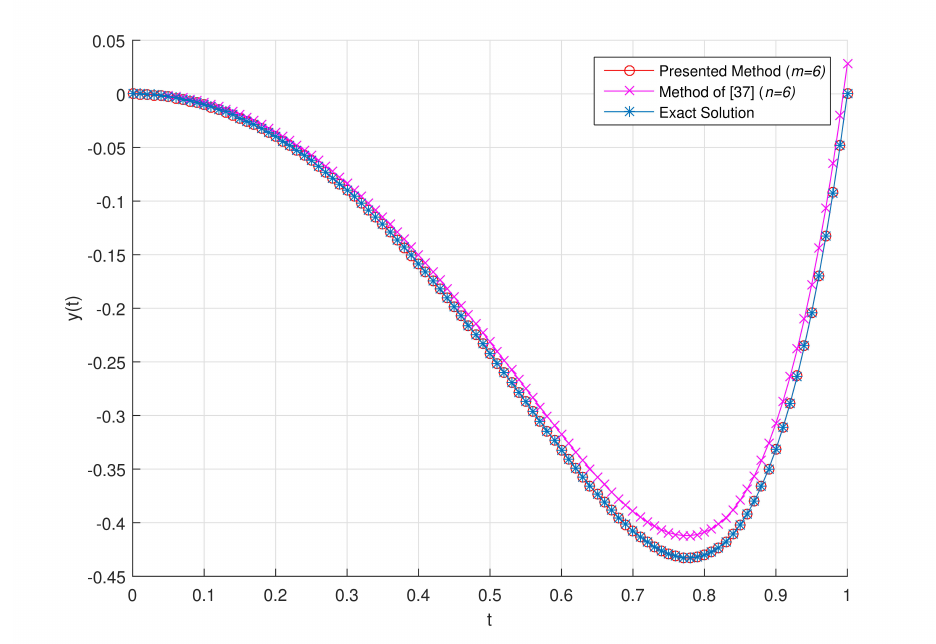
Figure 2. The comparison between exact solution and the numerical solutions obtained by proposed method and the method of [59] with m , n =